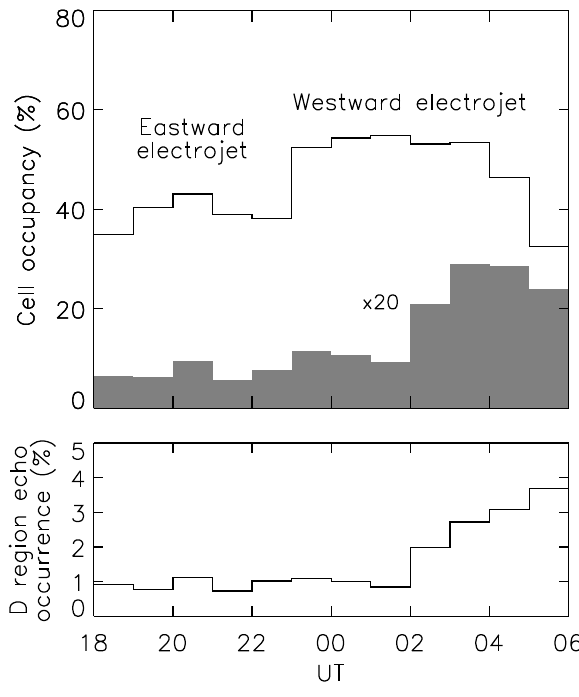
Fig. 5. The UT dependence of the occurrence of E region echoes and D region echoes. These are measured as field-of-view cell oc- cupancy, the average proportion of radar cells that contain E re- gion echoes (defined as those from an altitude below 150km, solid curve) and D region echoes (defined as those from an altitude be- low 100km with spectral widths less than 20ms − 1 , grey bars). The proportion of echoes from the D region is indicated in the lower